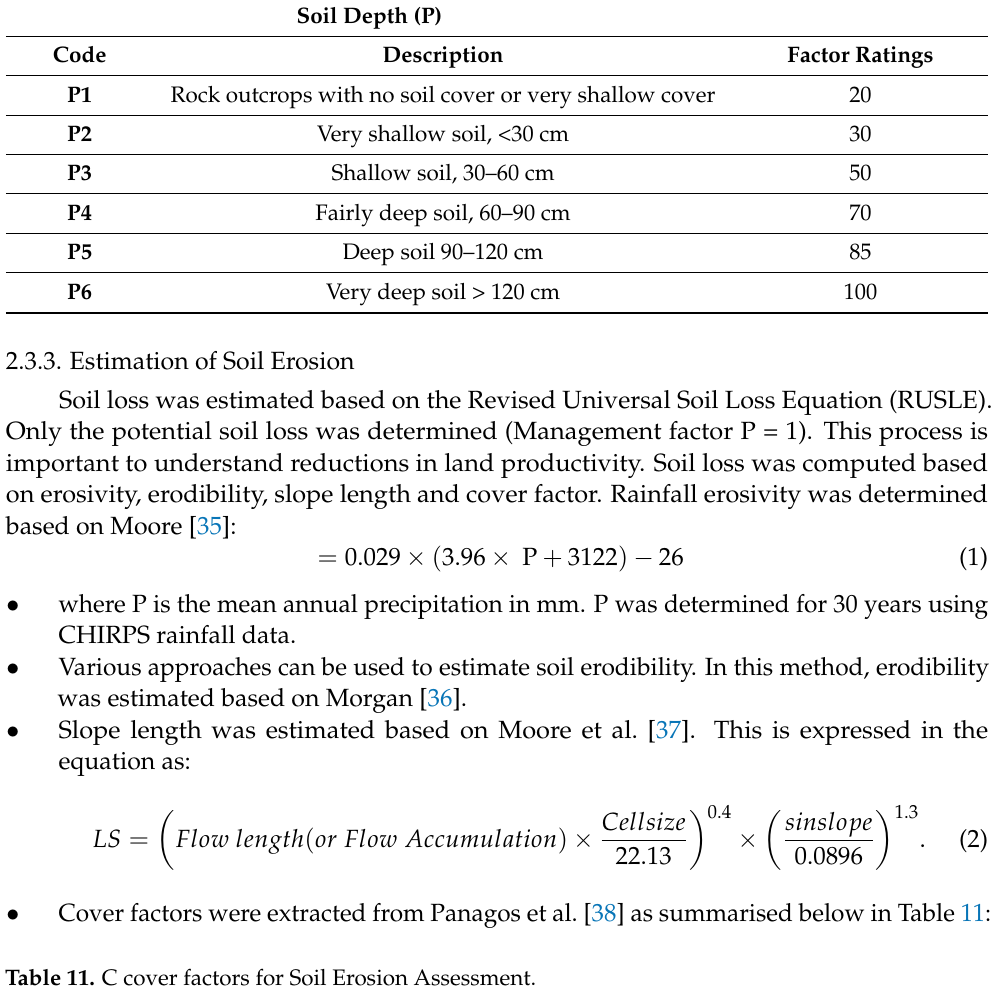
Table 10. Factor ratings of topography (slope depth—cm).